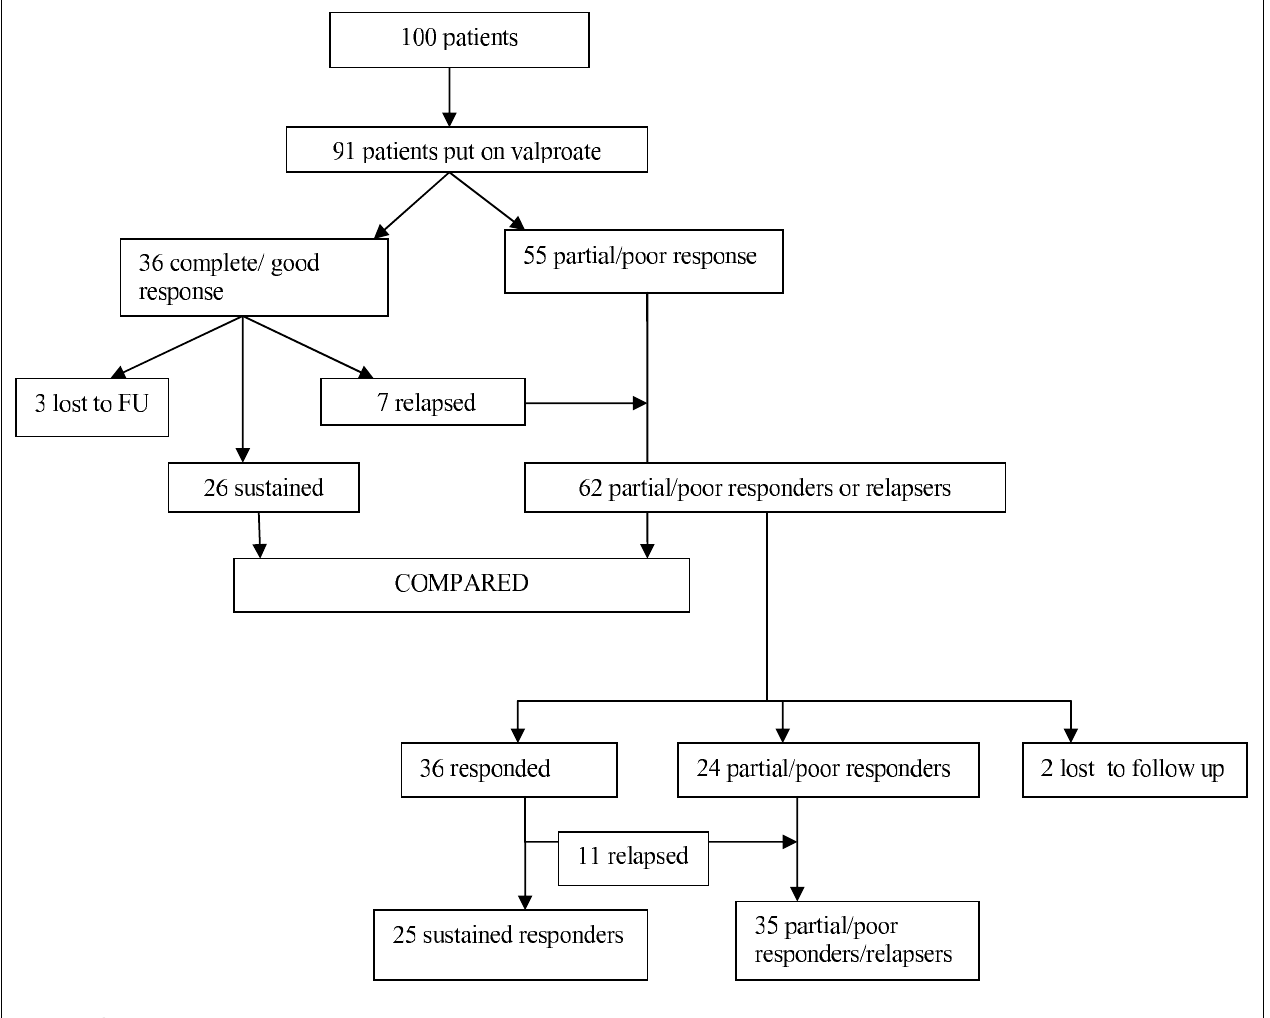
FIGURE 1 | Showing enrollment of patients and